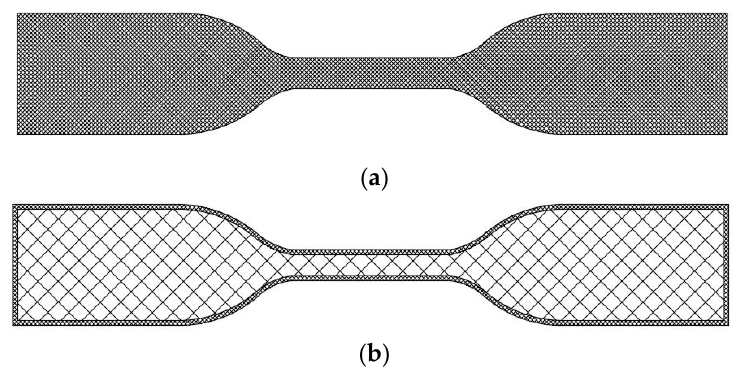
Figure 5. Infill scheme of upper and lower layers ( a ); infill scheme of intermediate layers ( b ).